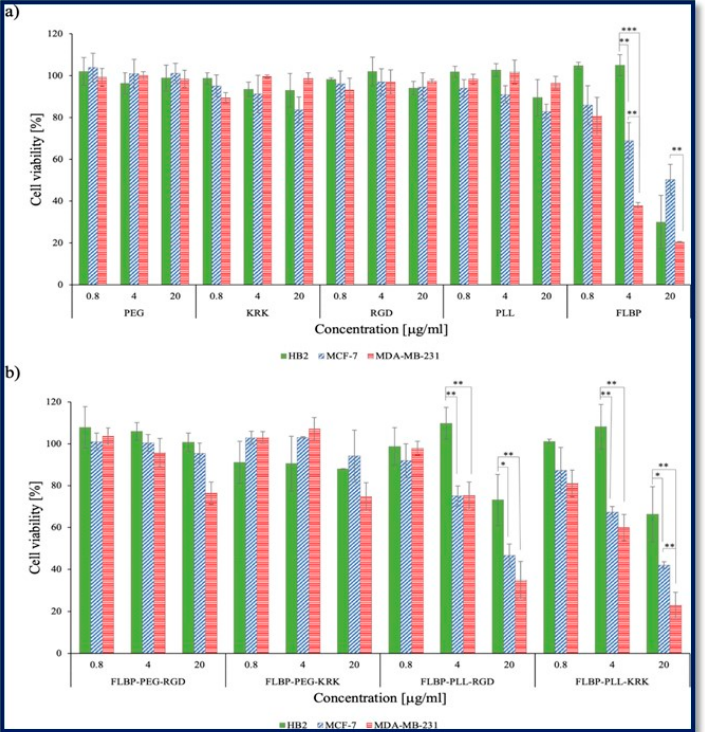
Figure 22. Cell viability [%] of three different cell lines HB2, MCF-7, and MDA-MB-231 after 72 h incubation with various concentrations (0.8, 4, 20 µg mL − 1 ) of ( a ) PEG, KRK, RGD, PLL, and FLBP and ( b ) FLBP-PEG-RGD, FLBP-PEG-KRK, FLBP-PLL-RGD, and FLBP-PLL-KRK determined by MTT assay. Data are normalized to control (cells incubated without any additives [0 µg mL − 1 ]) and